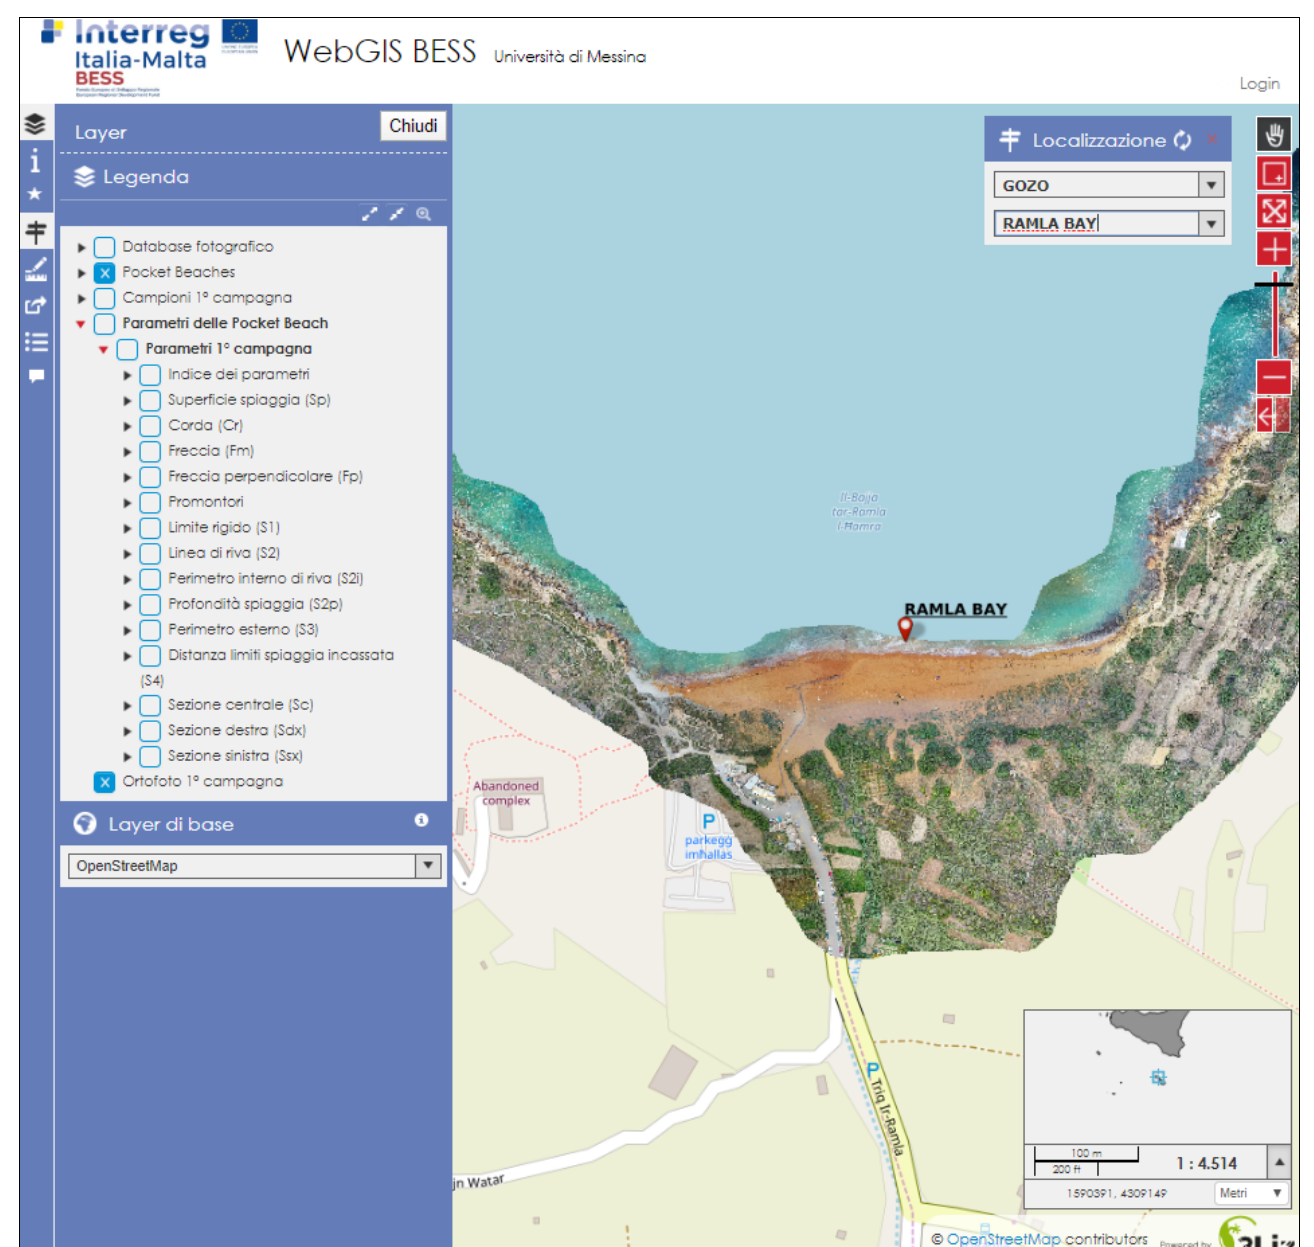
Figure 6. Visualization on the WebGIS platform of the PB of Ramla Bay (Gozo).